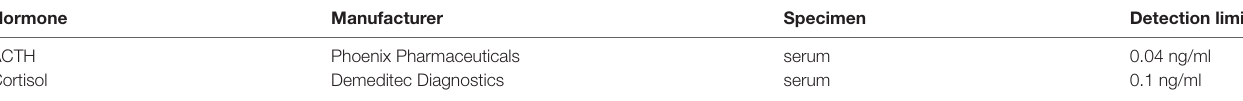
TABLE 1 | Kit specifications for each hormone.